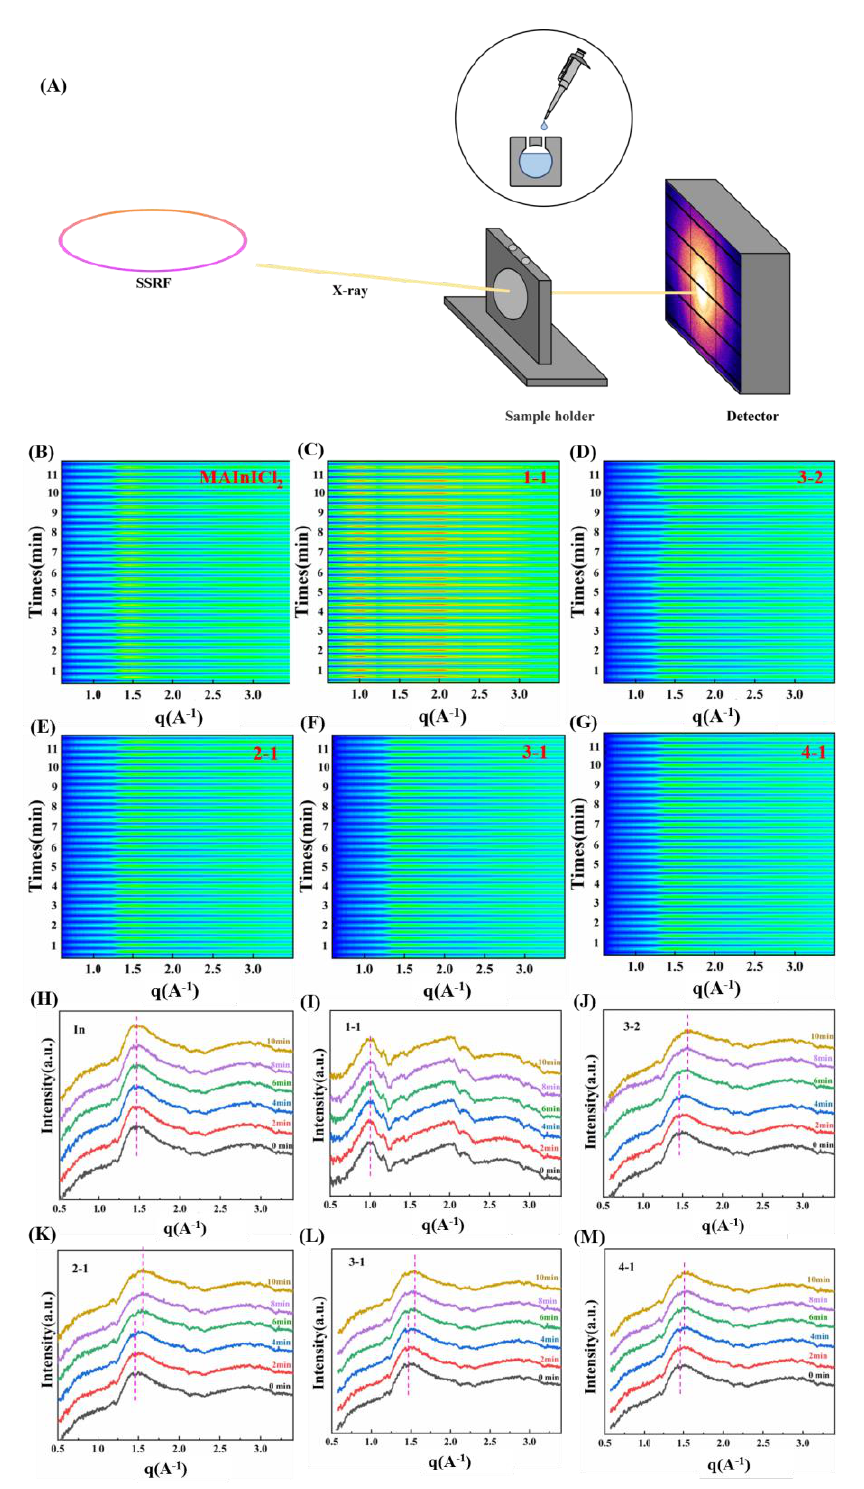
Figure 4. In situ GIWAXS measurements of MAInICl 2 perovskite precursor solution and different ratios of MAInICl 2 perovskite precursor solution mixed with digestion solution. ( A ) Diagram of GIWAXS experimental setup for in situ testing liquid samples. ( B – G ) Contour plots of integrated 1D-GIWAXS spectra of MAInICl 2 perovskite precursor solution and mixed solutions of different proportions (each data interval is 20 s). ( H – M ) Images of 1D-GIWAXS integral spectra of MAInICl 2 perovskite precursor solution and mixed solutions of different proportions at six time points (0 min, 2 min, 4 min, 6 min, 8 min and 10